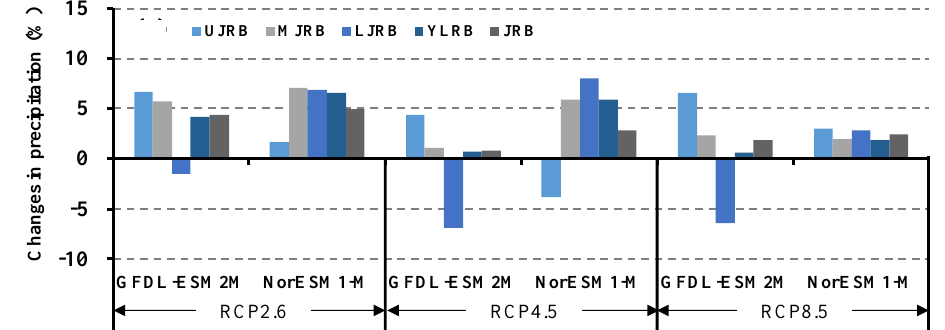
Figure 12. Changes in mean precipitation for 2021 to 2050.